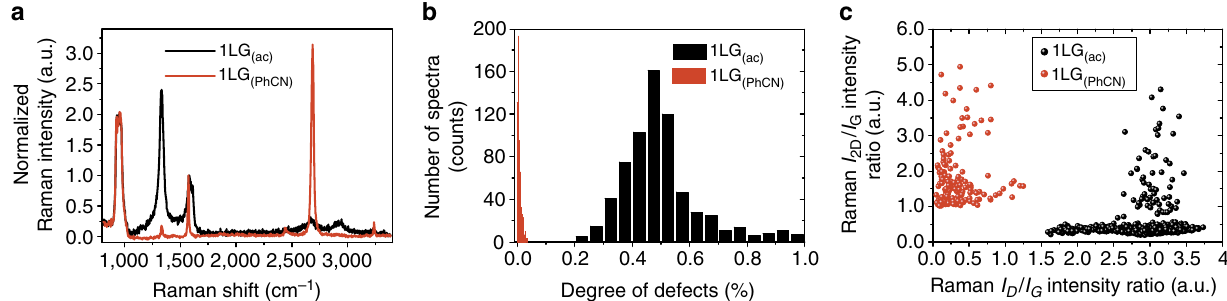
Figure 5 | Statistical Raman spectroscopy of exfoliated graphene. ( a ) Comparison of representative Raman spectra carried out on large-area films (50 (cid:4) 50 m m 2 ). ( b ) Statistical histogram representation of defect densities of the entire SRM map in Fig. 4c. ( c ) Scatterplot of the Raman intensity ratio dependency: The I D / I G versus I 2D / I G Raman intensity ratio reveals the effect of PhCN retaining the high quality of 1LG (PhCN) in contrast to air exposed 1LG (ac) graphene